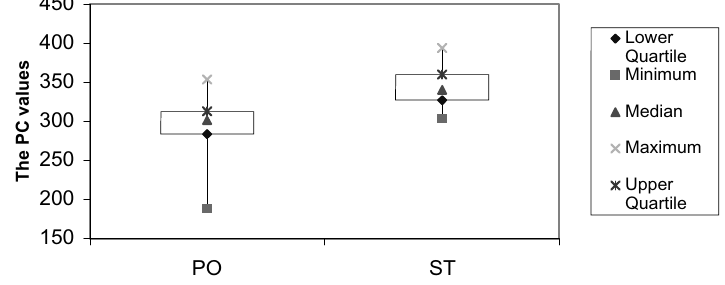
Fig. 1. Principal Component analysis Result. The t test shows difference between the PO and ST groups ( t = 4.2, df = 24, P =